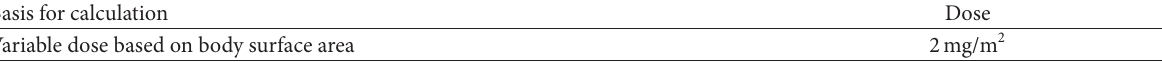
Basis for calculation Variable dose based on body surface